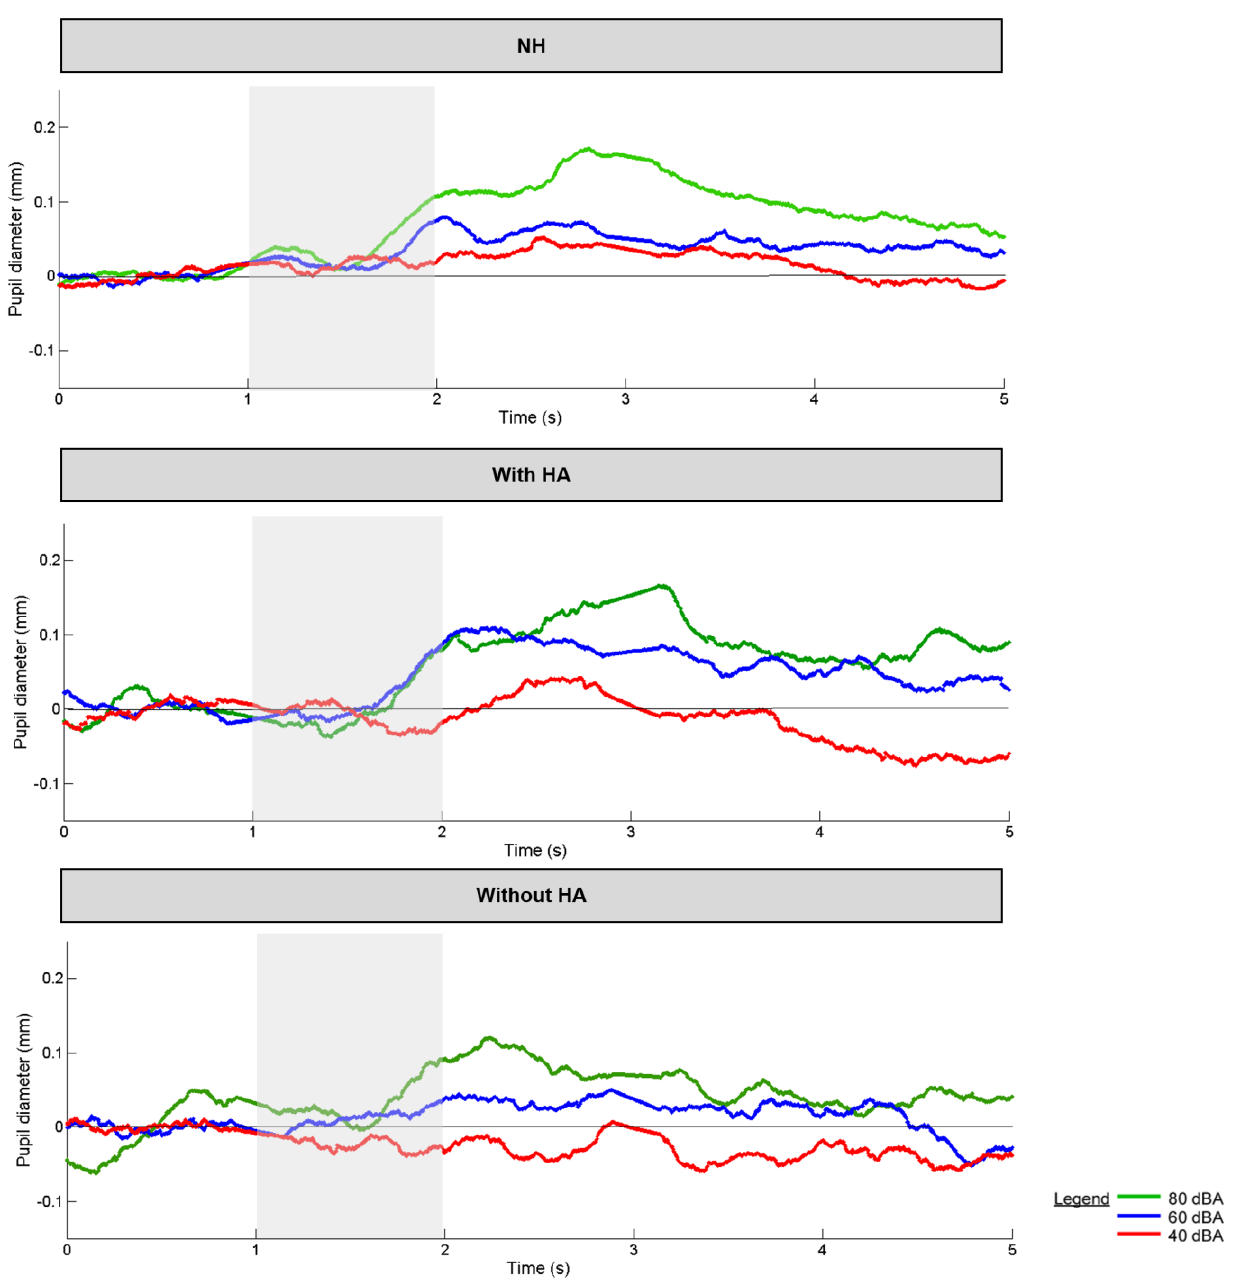
Figure 4. Peak pupil diameter as a function of time for mean NH group and the HA group ( aided and unaided ) after a tone burst at 1 kHz with 1 s length ( grey shaded ).